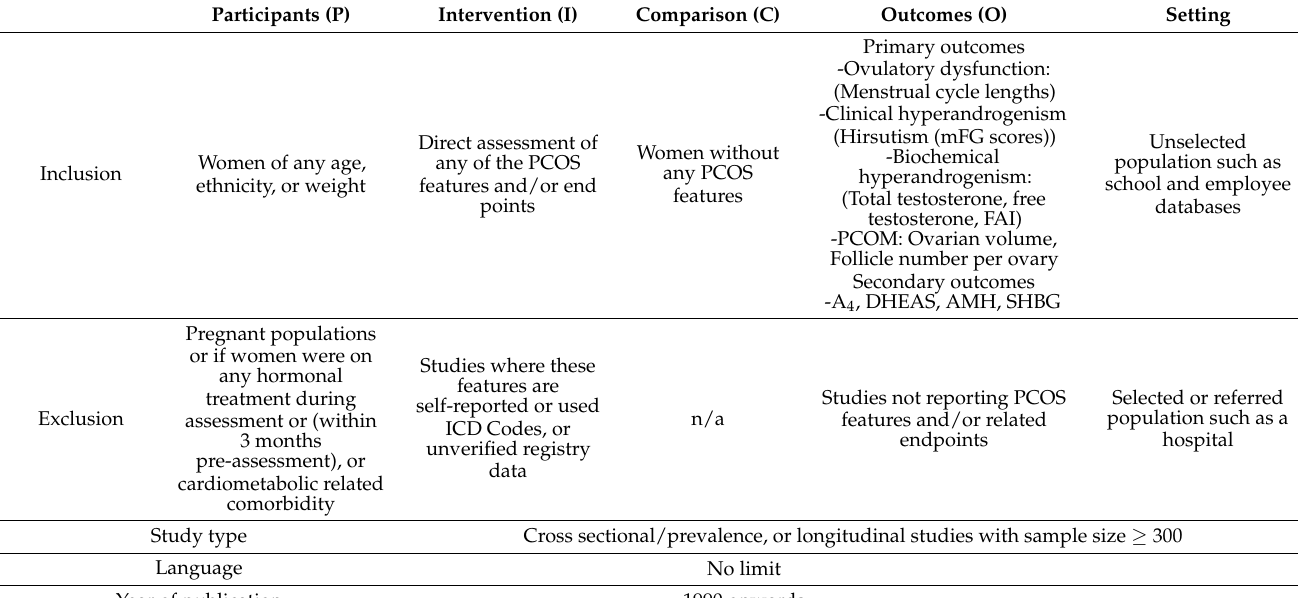
Table 1. PICO table for the study selection